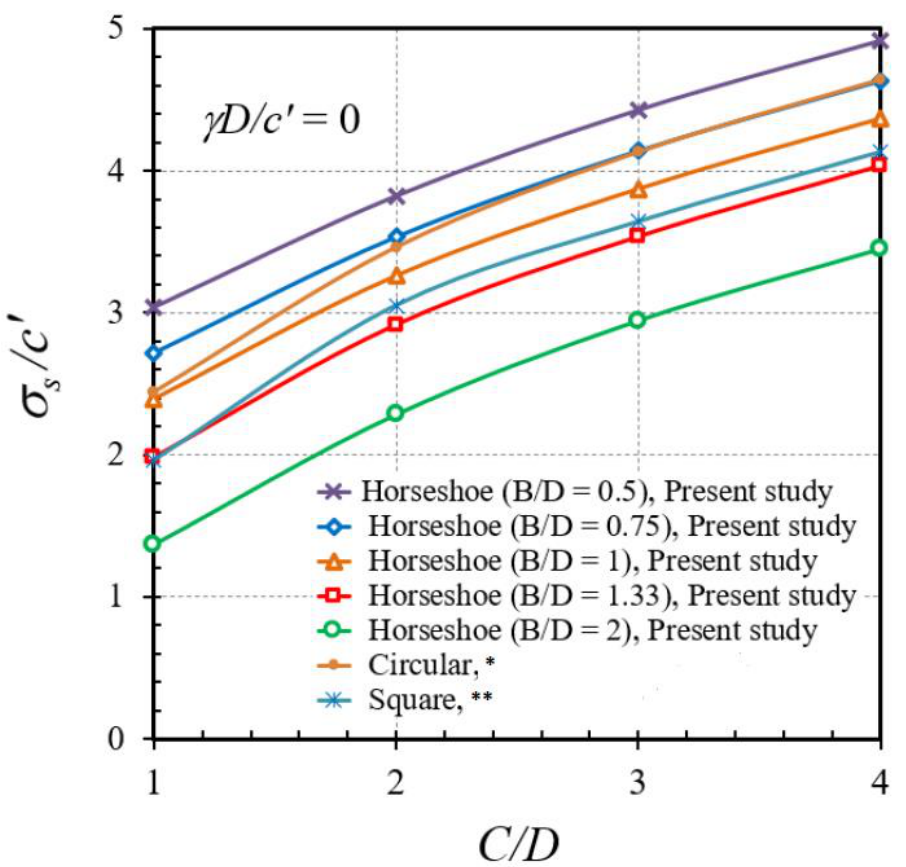
Figure 12. Comparison of the stability factors σ s / c’ for different shapes of tunnels ( ϕ = 0°). * Yama- moto et al. [19], ** Yamamoto et al. [20].